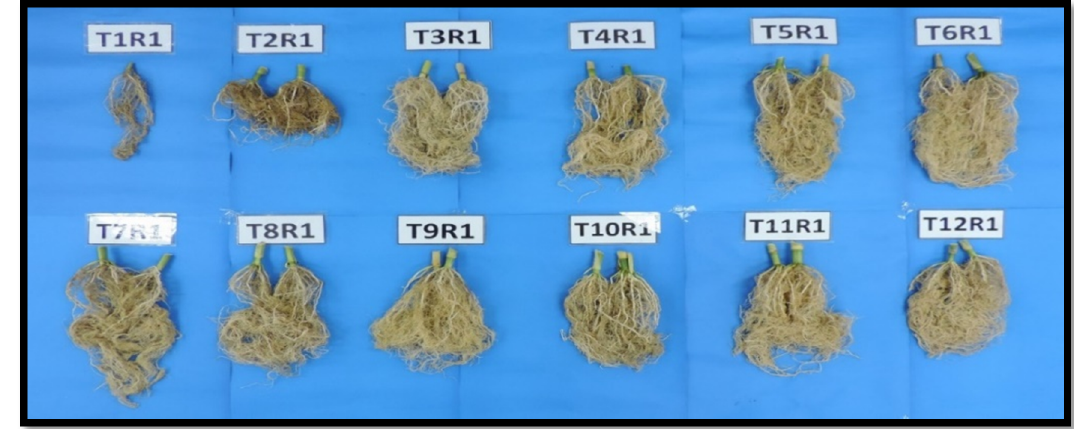
Figure 3. Effects of treatments on maize plants’ root at tasseling stage. (Note: T represents treatment and R represents replication).